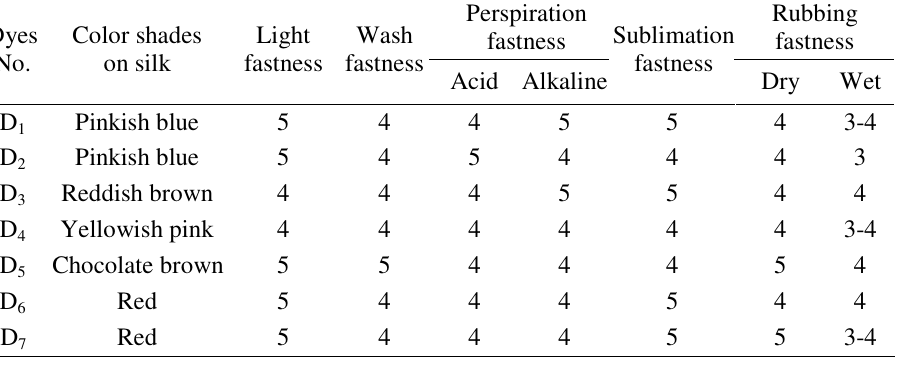
Table 3. Results of acid azo dyeing and various fastness properties of dyes on silk.